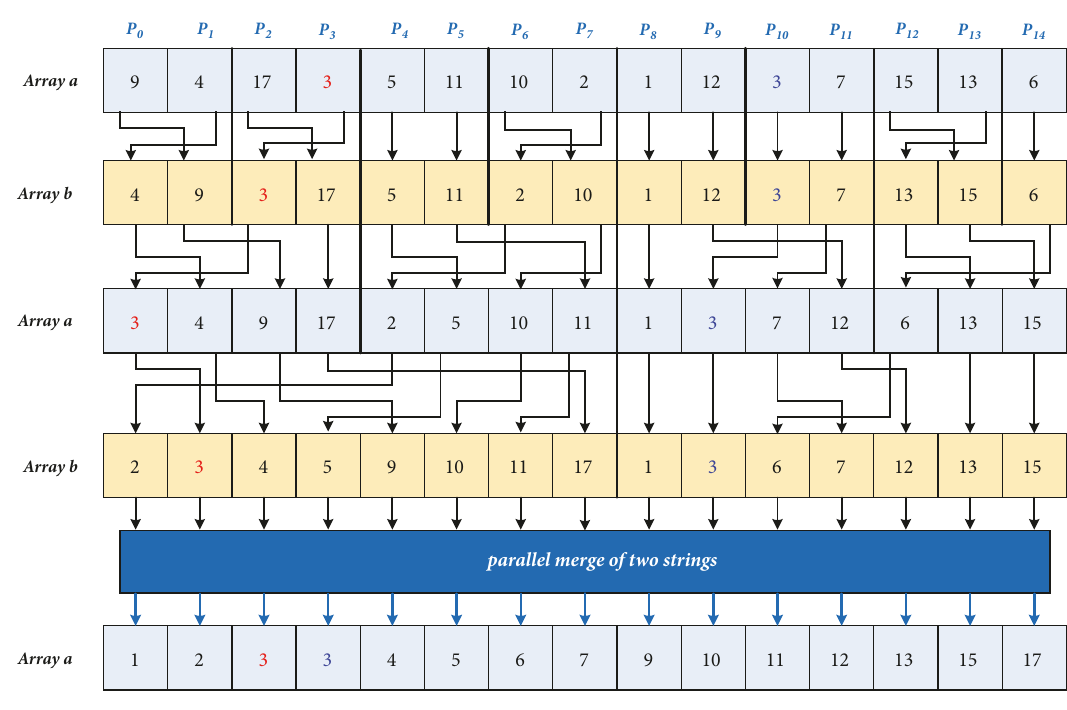
Figure 5: Fully Flexible Parallel Merge Sort Algorithm sorting the input array. The method is a stable method in the sense of keeping the order of arranging elements of the same value in a sorted sequence. In the drawing, this is shown on the element with value 3, which has been marked with different colors. In the sorted sequence, the elements remain in the stacking order, such as that they had in the input of not sorted sequence.